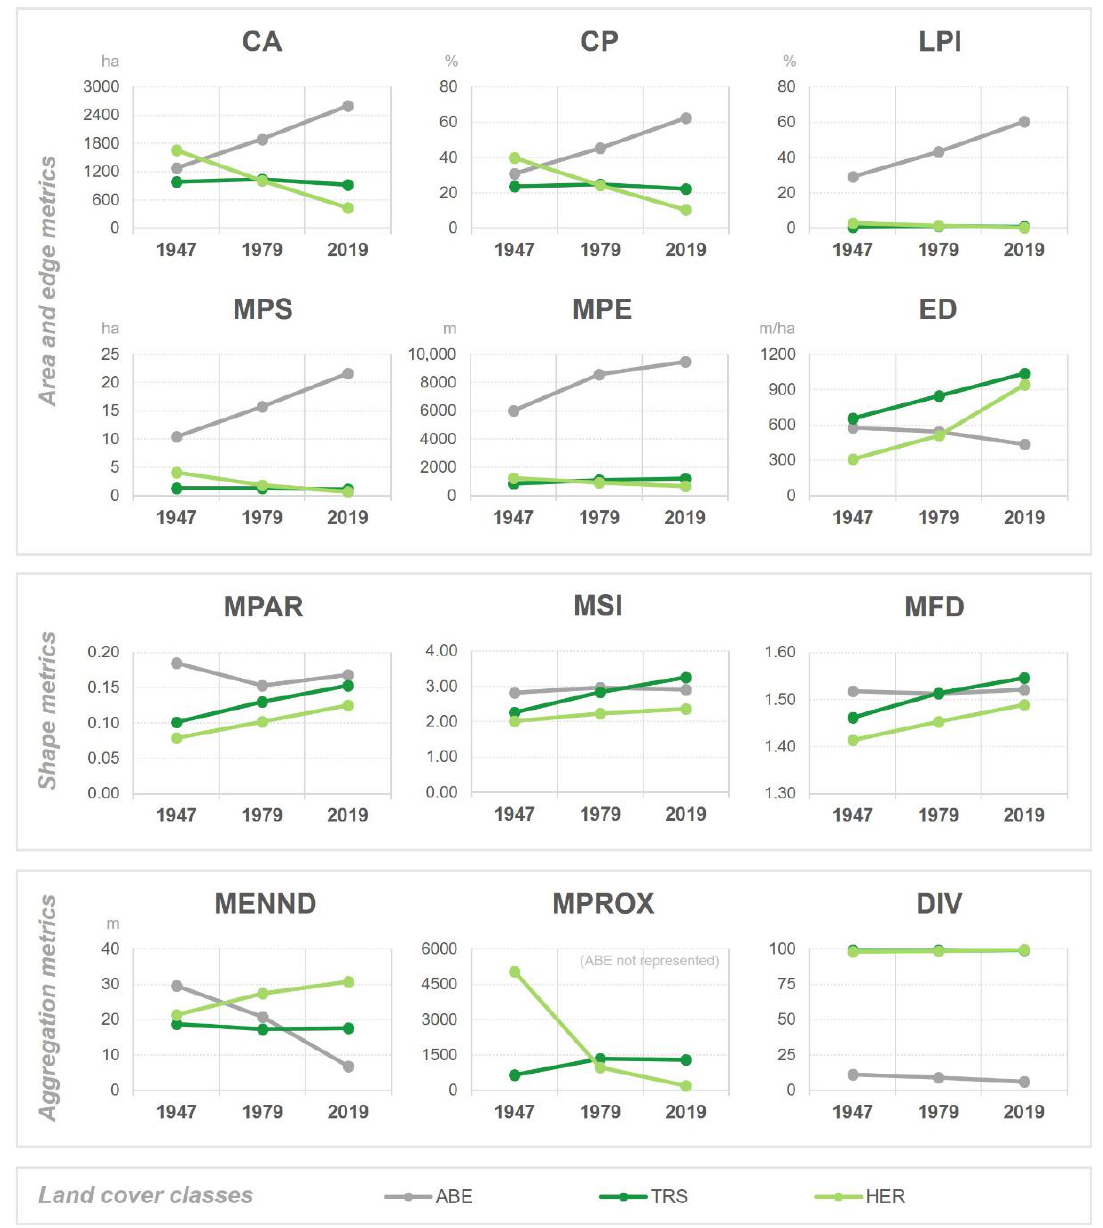
Figure 6. Evolution of spatial metrics at the class level, for the period 1947 – 1979 – 2019 (see Tables A2 – A4 for detailed values). CA: total class area; CP: class proportion; LPI: largest patch index; MPS: mean patch size; MPE: mean patch edge; ED: edge density; MPAR: mean perimeter – area ratio; MSI: mean shape index; MFD: mean fractal dimension; MENND: mean Euclidean nearest neighbour distance; MPROX: mean proximity index; DIV: division index.